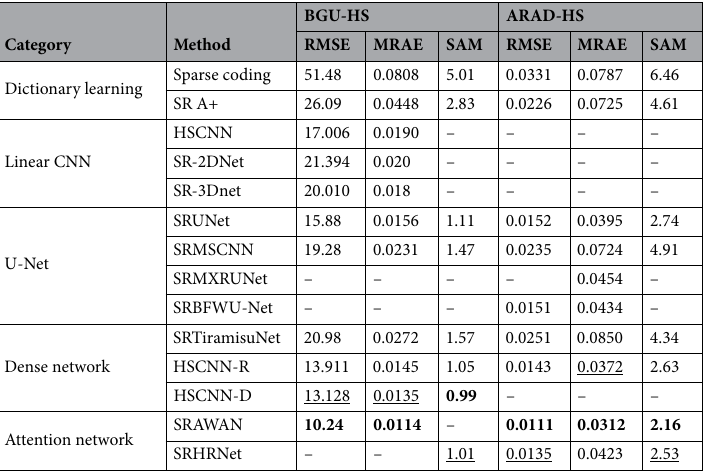
Table 4. Reconstruction accuracy comparison of representative SR methods in terms of RMSE, MRAE and SAM on the BGU-HS and ARAD-HS datasets. Top two best results are highlighted in bold and underline